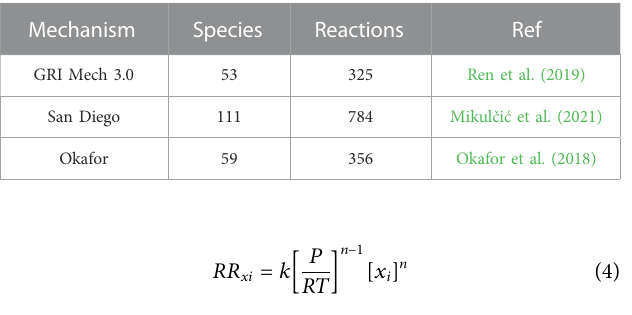
TABLE 2 Three mechanisms used in the current work.